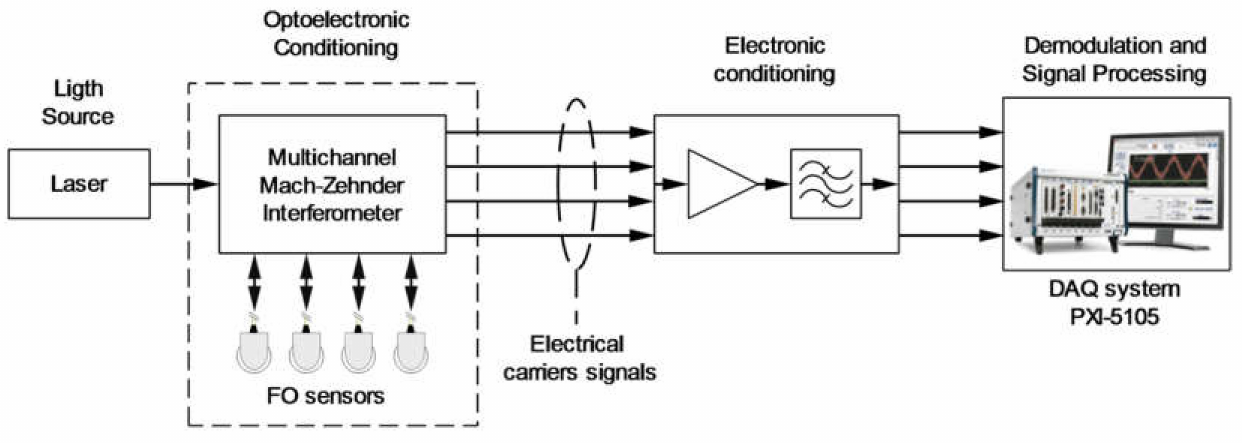
Figure 5. Detection optical interferometer of four